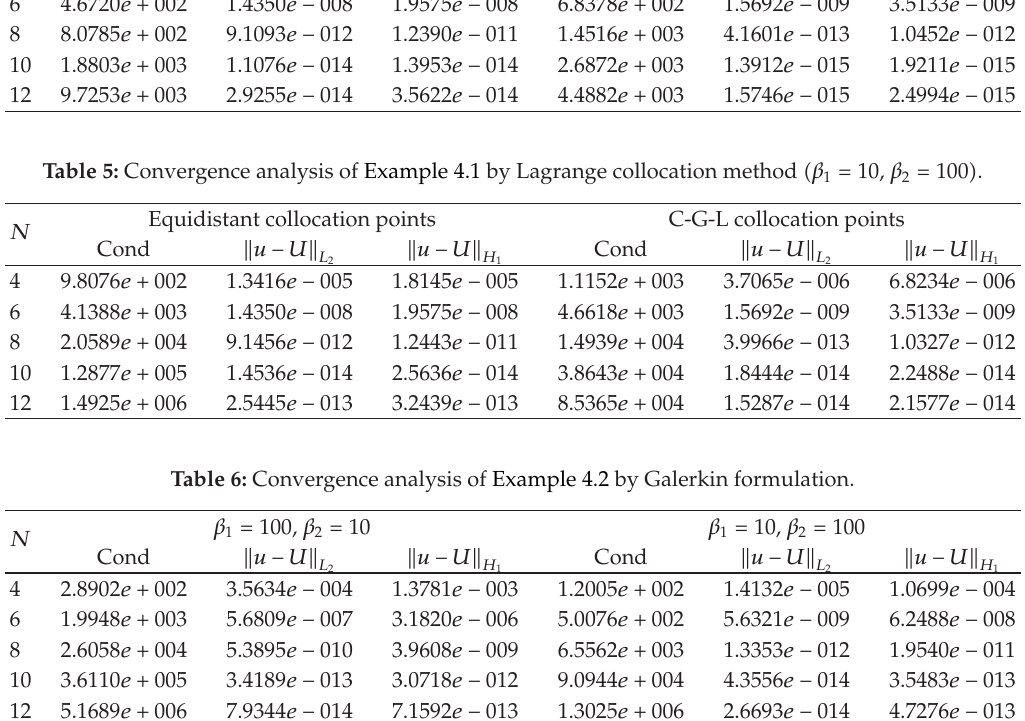
Table 7: Convergence analysis of Example 4.2 by Bernstein collocation method (cid:5) β